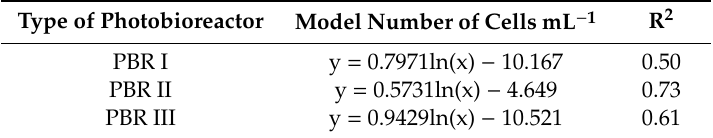
Table 3. Mathematical form of the approximate number of cells per mL read from the densitometer indications for C. vulgaris BA0002a, carried out under strictly defined conditions.